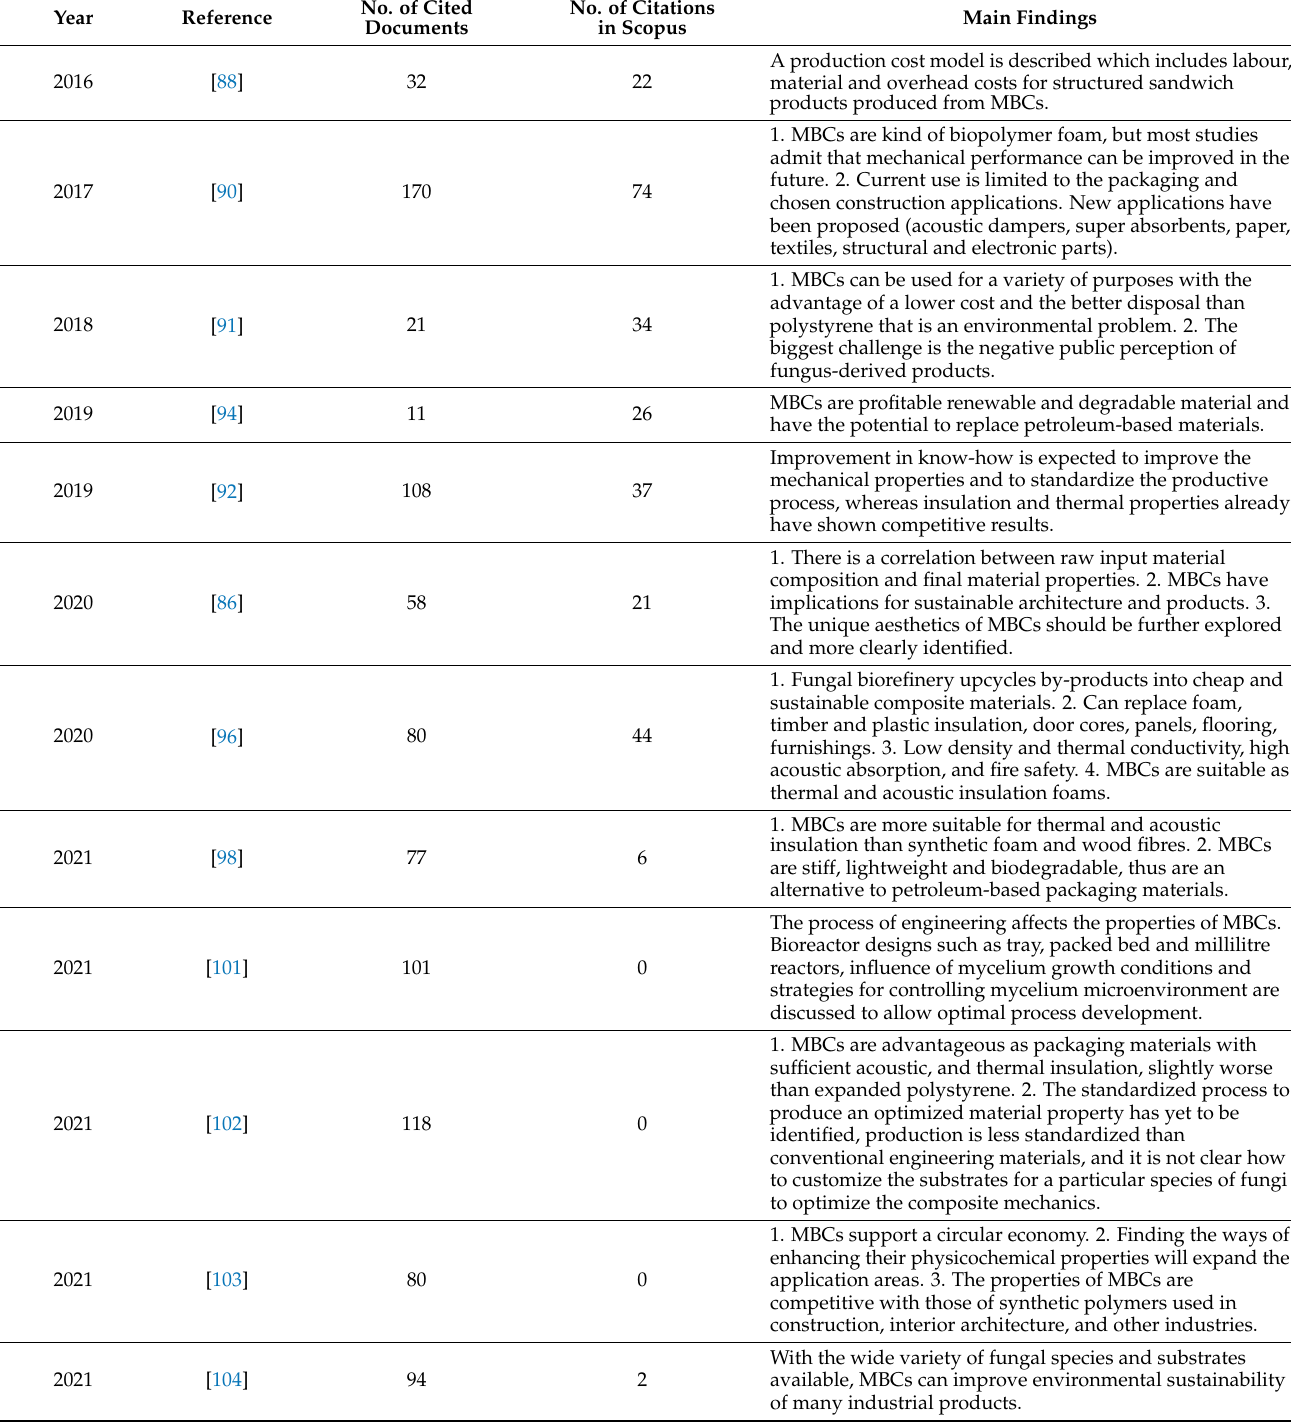
Table 3. List of scientific review publications for mycelium-based composites for art, architecture, and interior